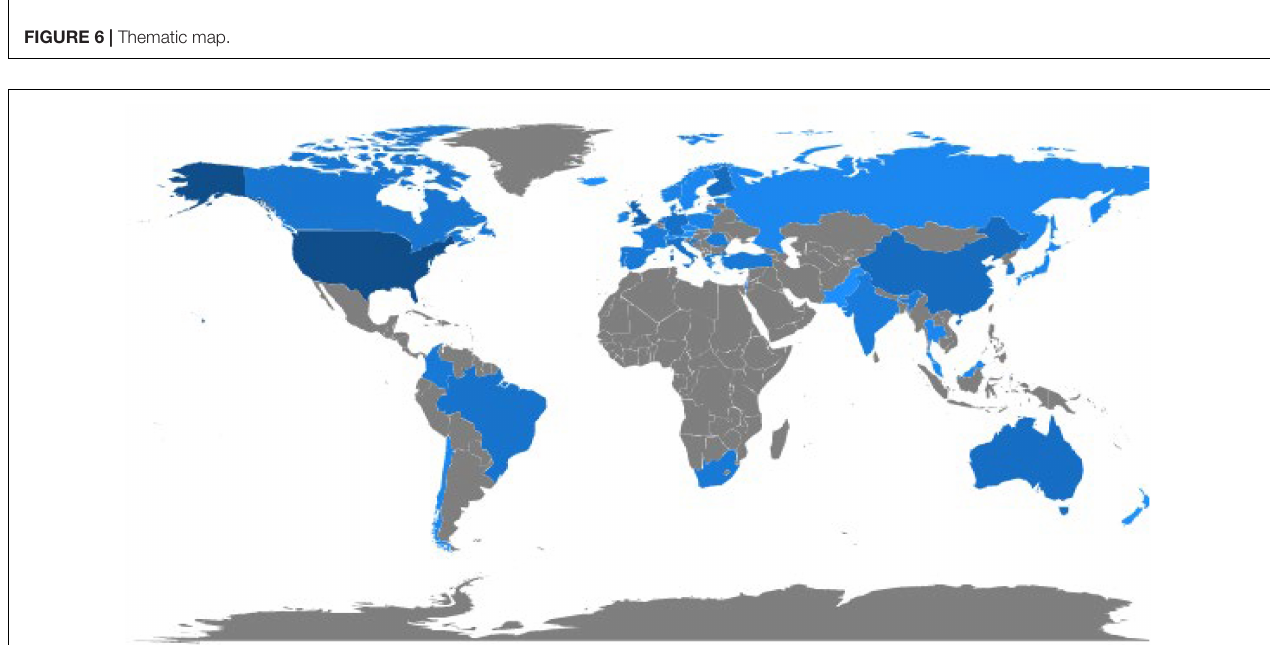
FIGURE 6 | Thematic map.